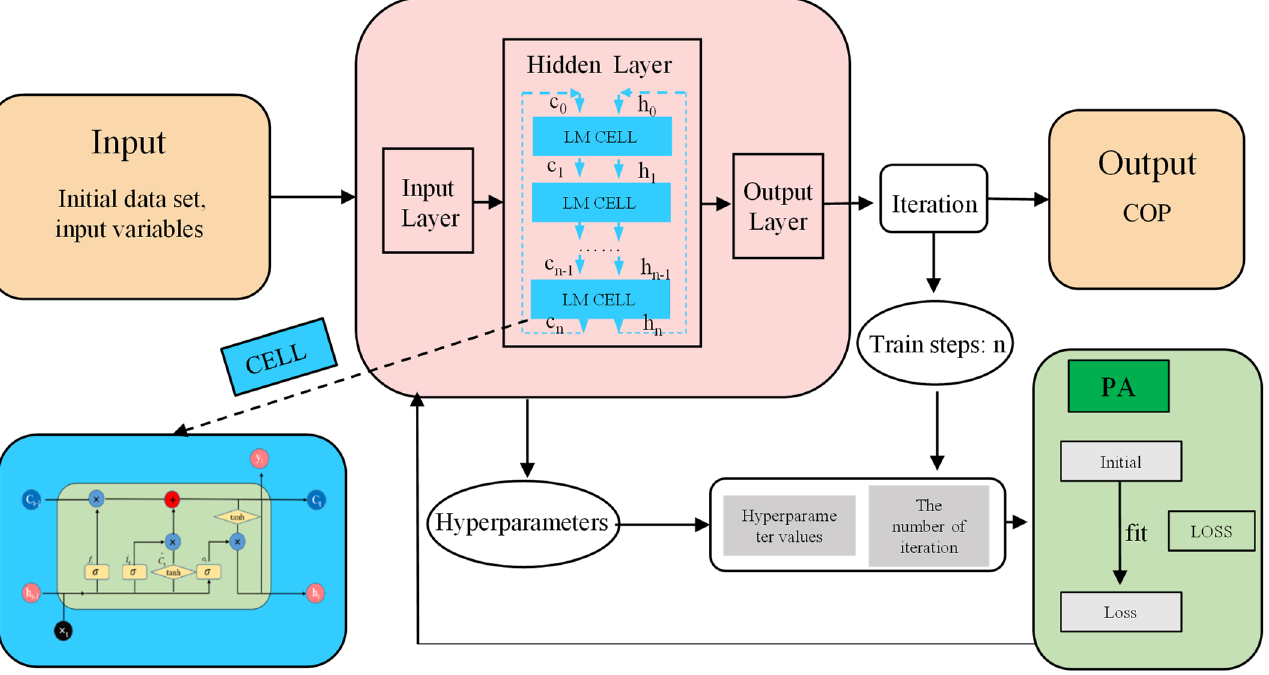
Figure 6. Schematic of a typical LM cell.